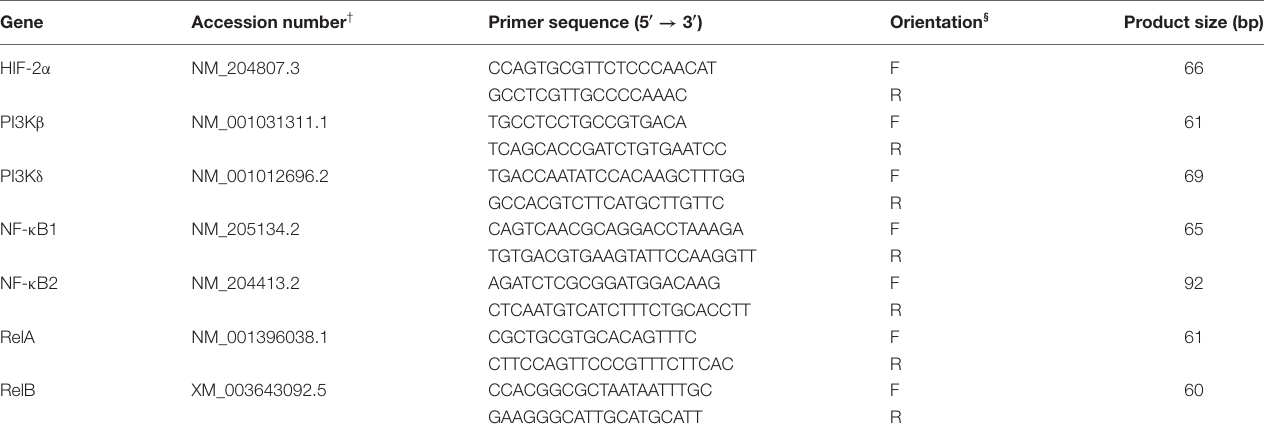
TABLE 1 | List of qPCR chicken-specific oligonucleotide